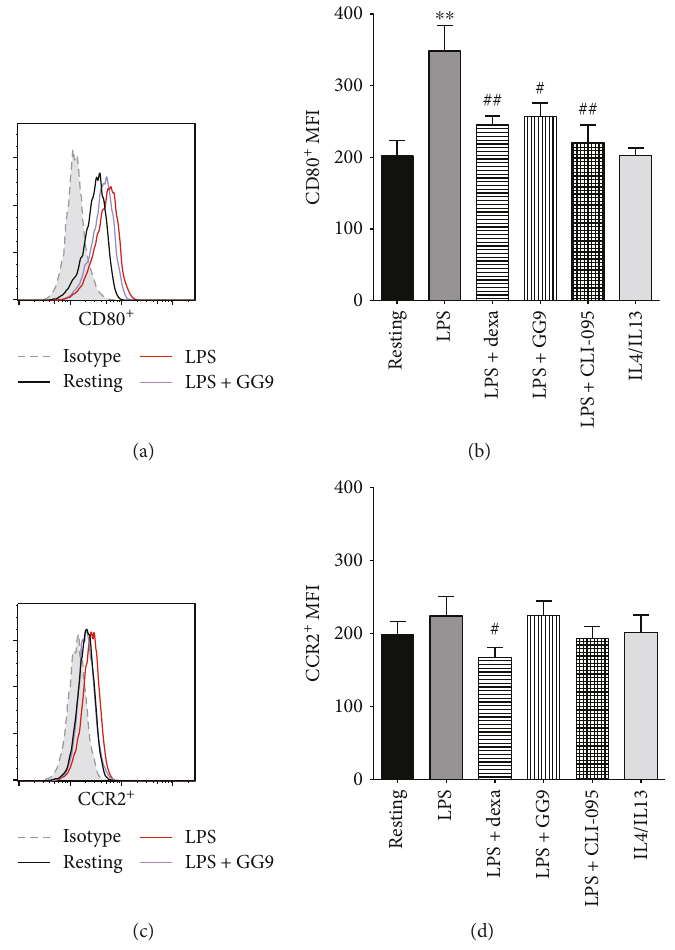
Figure 1: E ff ects of GG9, dexamethasone (dexa), and CLI-095 on LPS-induced activation of M1 macrophage markers CD80 and CCR2. Cells were pretreated with dexa, GG9, and CLI-095 for 30min and then polarized using either 0.1 μ M LPS (M1) or 20ng/ml IL-4 plus 5ng/ml IL-13 (M2) for 24 h in RPMI +10% FBS as described in Materials and Methods. (a, c) Representative fl ow cytometry assays for CD80 + and CCR2 + cells. Bar graphs represent the mean ( ± SEM) of CD80 + (b) and CCR2 + (d) mean fl uorescence intensity (MFI) from 6 independent experiments. ∗∗ p < 0 01 versus resting; # p < 0 05 and ## p < 0 01 versus